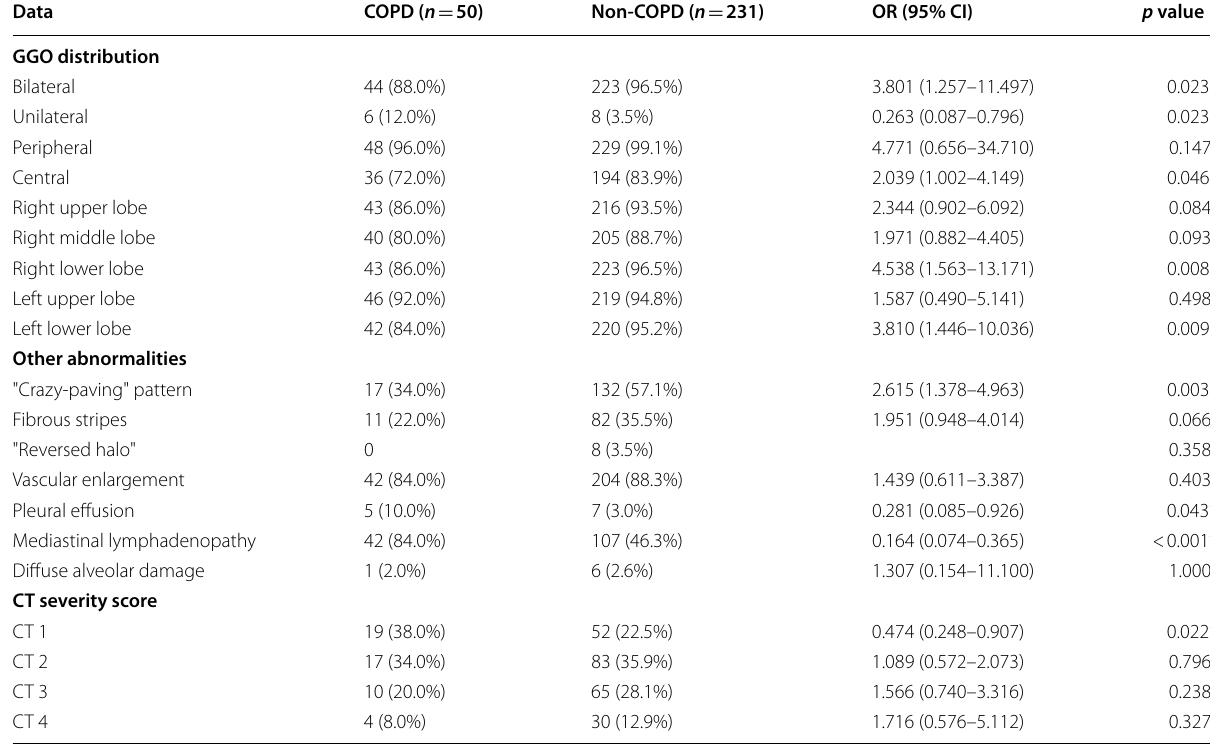
Table 3 Relevant CT chest findings